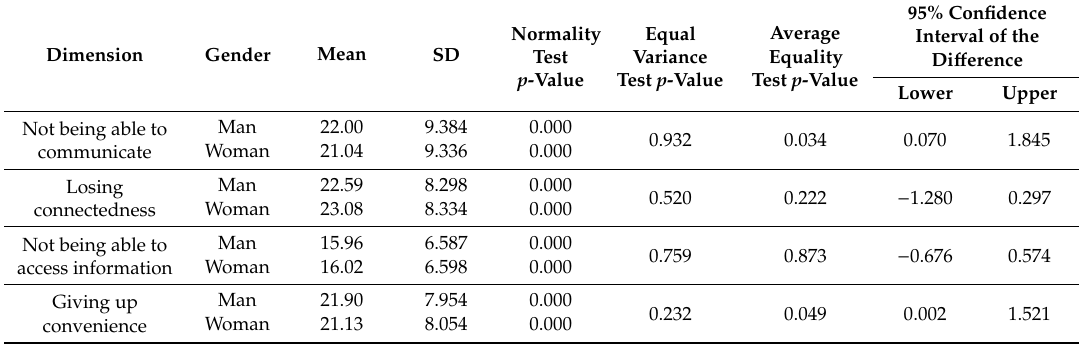
Table 2. Statistical testing by